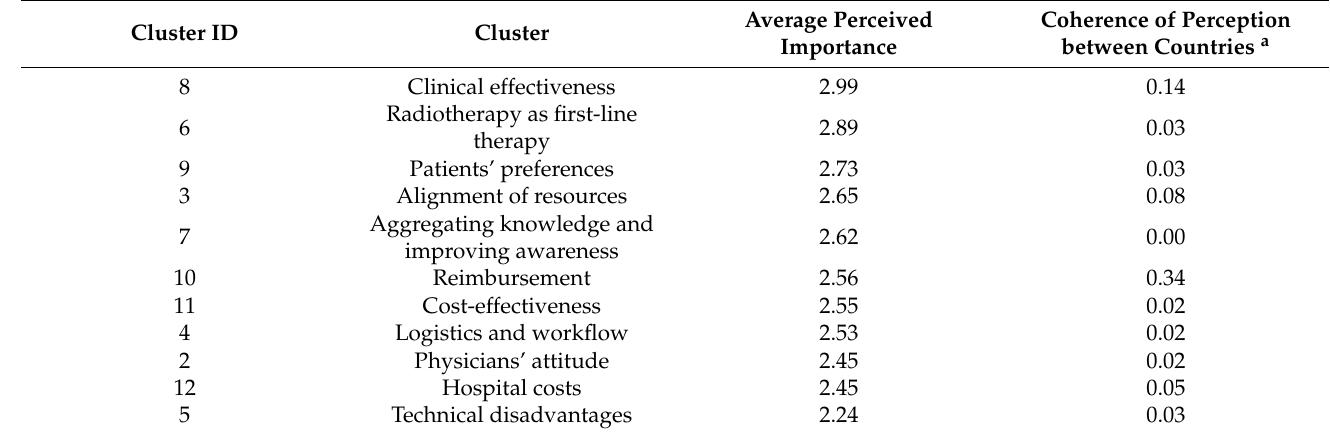
Table 3. Clusters ranked in order of importance and coherence between countries.